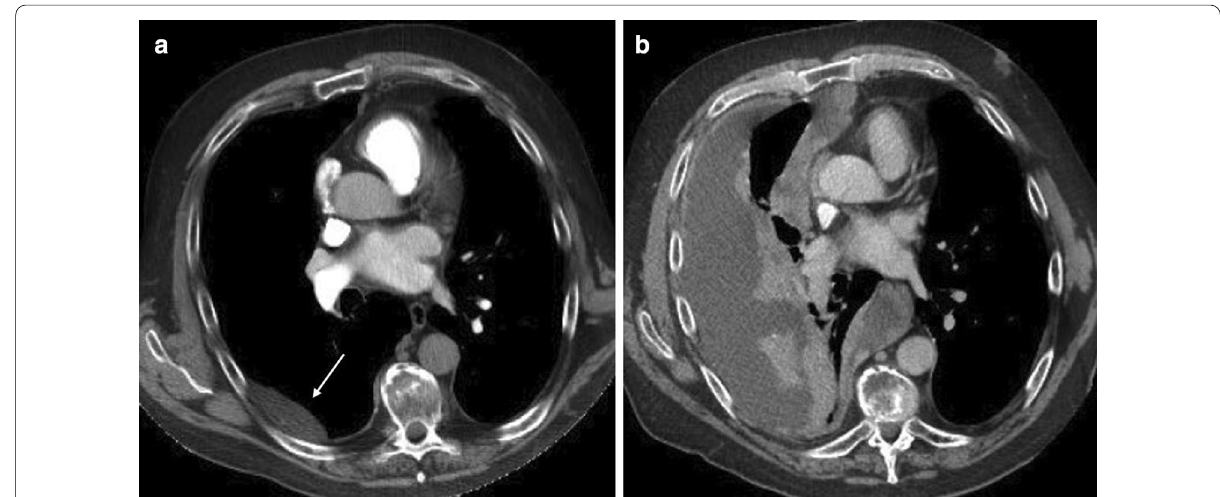
Fig. 8 Diagnosis: angiosarcoma. Technique: contrast-enhanced chest CT. Description: A 64-year-old man with no history presented with progressive shortness of breath. The initial contrast-enhanced CT scan ( a ) to rule out pulmonary embolism shows a well-delineated pleural-based oval lesion (arrow) in the base of the right lung. Findings are relatively aspecific. Follow-up CT examination 4 weeks later ( b ) shows prominent disease progression, with a large amount of fluid. Despite the relatively short time interval, there is a marked increase in pleural lesions, with widespread focal contrast enhancing pleural lesions in the right hemithorax. The rapid and aggressive progression points to the possible diagnosis of angiosarcoma, which was histologically